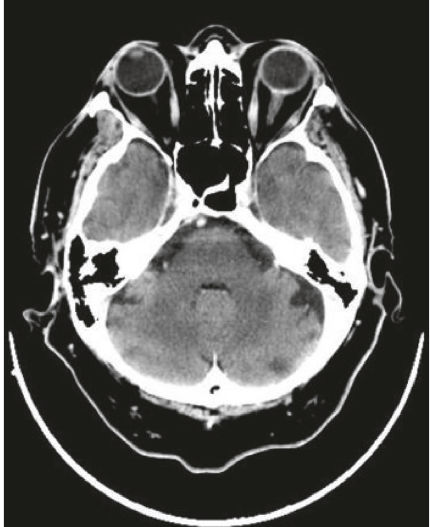
Figure 2: The CT scan performed after the end of the salvage therapy showed complete remission of the